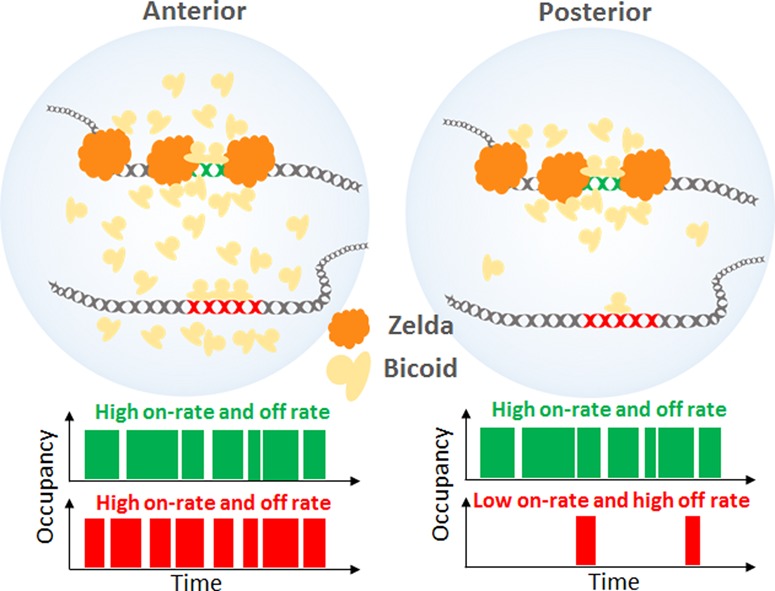
Model of ZLD-dependent modulation of the BCD on rate at specific loci in the posterior embryo. At high concentrations in the anterior of the embryo, all target sites are highly occupied. At low concentrations, loci with ZLD occupancy have an increased time-averaged occupancy through the formation of spatiotemporal hubs that enrich local concentrations and increase the on rate.